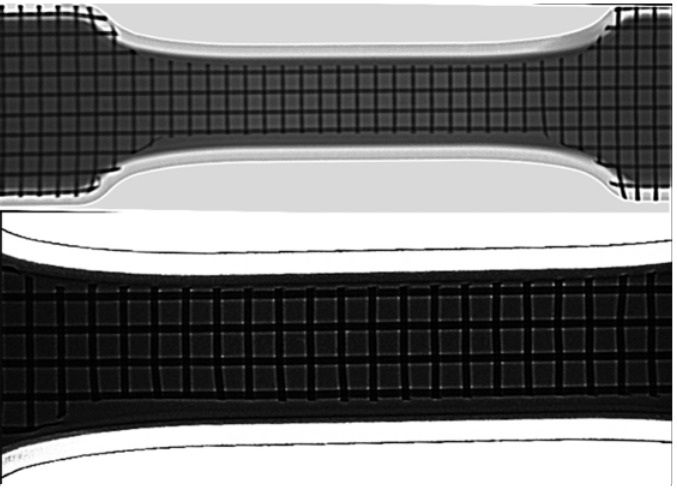
Figure 4: Results of radiography testing showing the wire mesh position and lack of filling at the wires